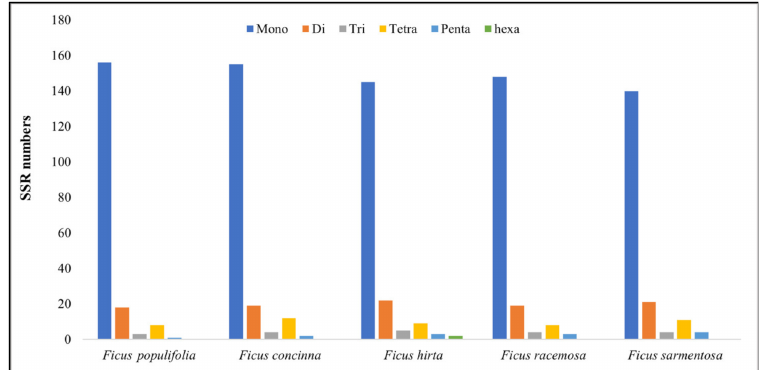
Figure 8. Number of different SSR types in the five Ficus plastomes.